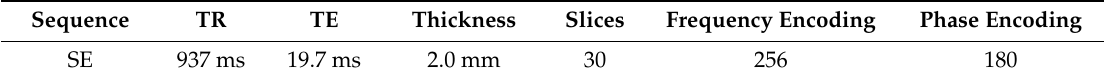
Table 3. MRI scan parameters for human crus.